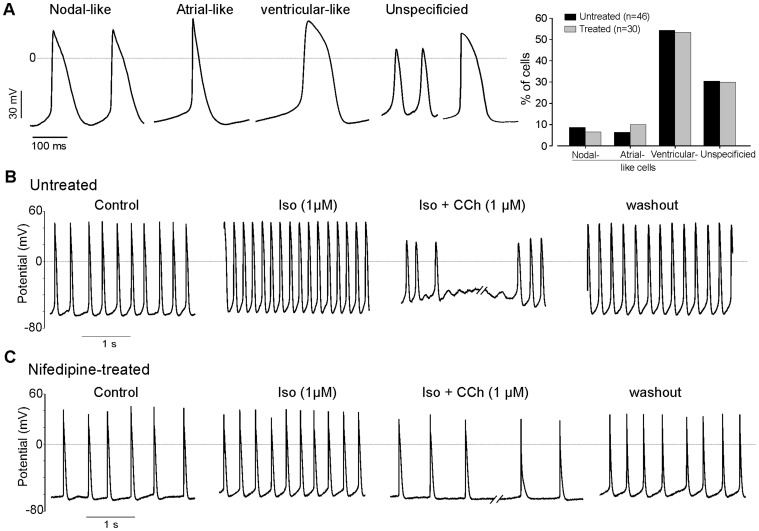
Nifedipine does not affect the generation of specific cardiac subtypes as well as the β-adrenergic and muscarinic regulation pathways.(A) Representative AP recordings from spontaneously beating ES cell-derived CMs revealed differentiation of nifedipine-treated cell into the different cardiac subtypes: nodal-, embryonic atrial- and embryonic ventricular-like CMs, note the presence of unspecified CMs (left panel). Statistic analysis (right panel) of different cardiac subtypes generated under control and nifedipine-treated cultures. (B–C) Representative AP of untreated (B) and nifedipine-treated (C) ES cells-derived CMs showed a prominent positive chronotropic effect of Iso (1 µM) (middle left) and negative chronotropic response to CCh (1 µM) (middle right) application. These effects could be partially reversed by washout. The dotted lines indicate the zero current level.